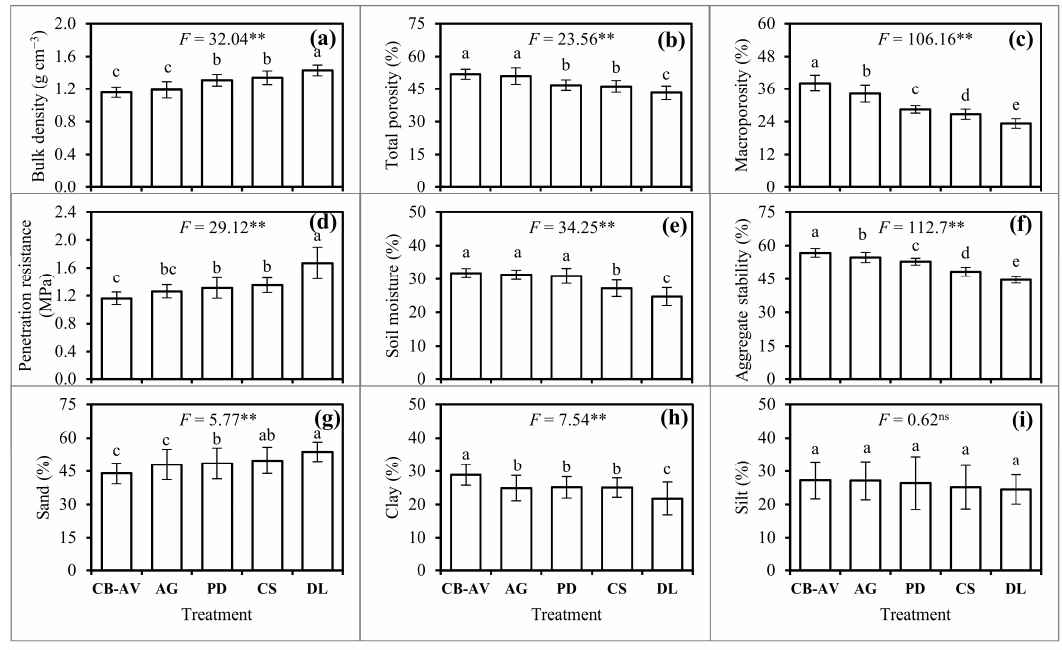
Figure 3. Mean values and standard deviation (SD) of soil physical properties: bulk density ( a ), total porosity ( b ), macroporosity ( c ), penetration resistance ( d ), soil moisture ( e ), aggregate stability ( f ), sand ( g ), clay ( h ), silt ( i ) in the different tree species treatments. Results of the ANOVAs ( F test and p value) are given. Different letters after means within each treatment indicate significant differences by Duncan’s test ( p < 0.05). Note: ** P < 0.01; ns : Not significant. CB ‐ AV = natural forest stand of Carpinus betulus L. ‐ Acer velutinum Boiss.; AG = plantation of Alnus glutinosa (L.) Gaertn.; PD = plantation of Populus deltoides L.; CS = plantation of Cupressus sempervirens L. var. horizontalis (Mill.) Gord.; DL = degraded land without trees.